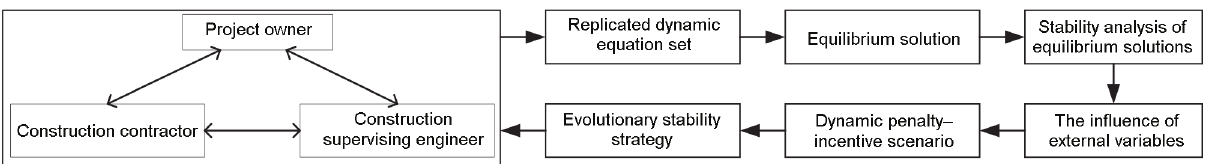
Figure 1. Framework of the proposed